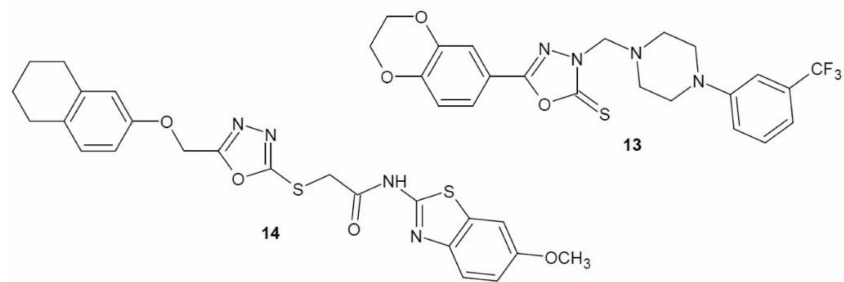
Figure 6. 1,3,4-Oxadiazole derivatives with activity of focal-adhesion kinase